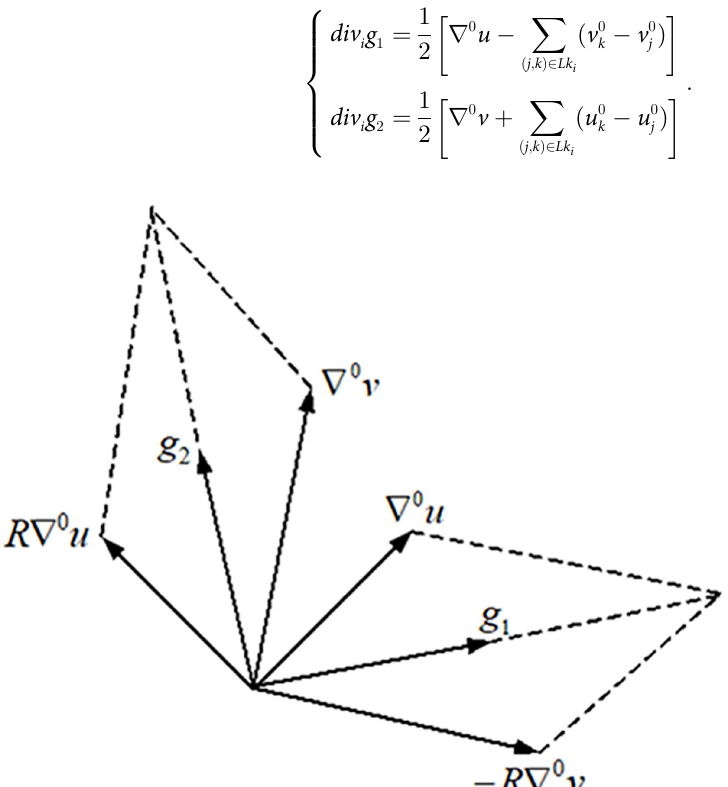
Fig 7. Illustration of constructing two guidance vector fields from two initial